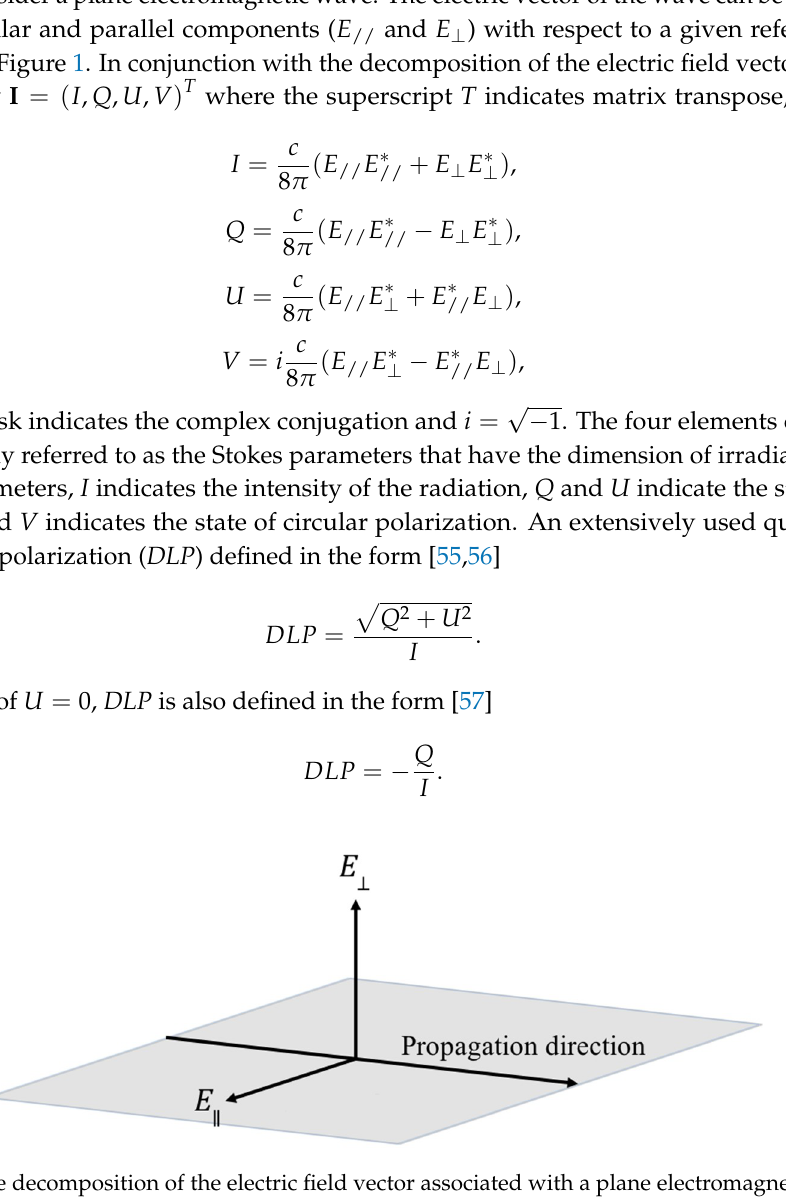
and E ) with respect to a reference plane. ^ //